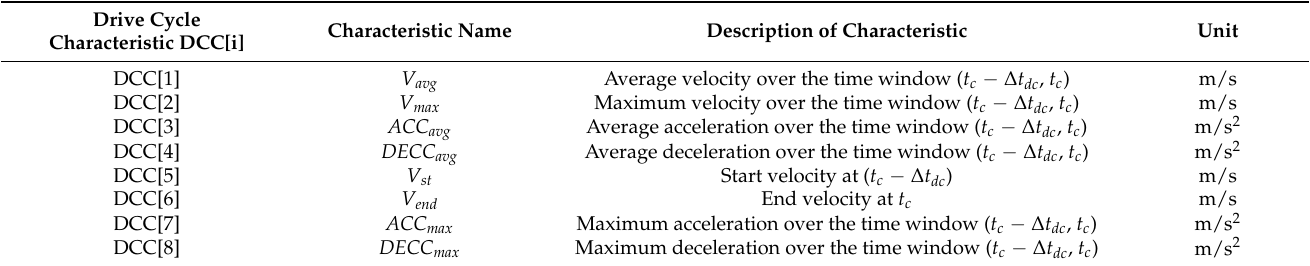
Table 2. Drive cycle characteristics and their